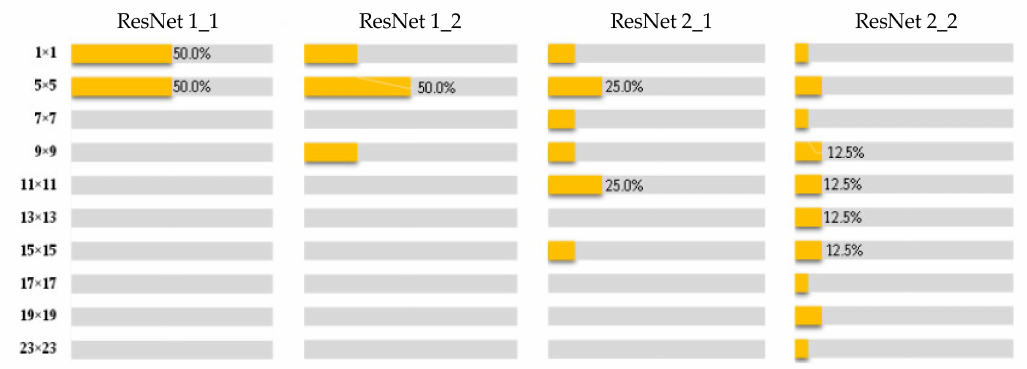
Figure 4. Distribution of the receptive field of the series structure of four Inception modules.